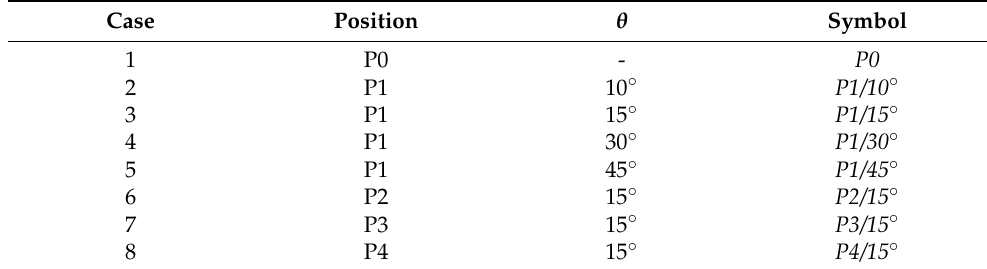
Table 1. The proposed conditions for simulation.